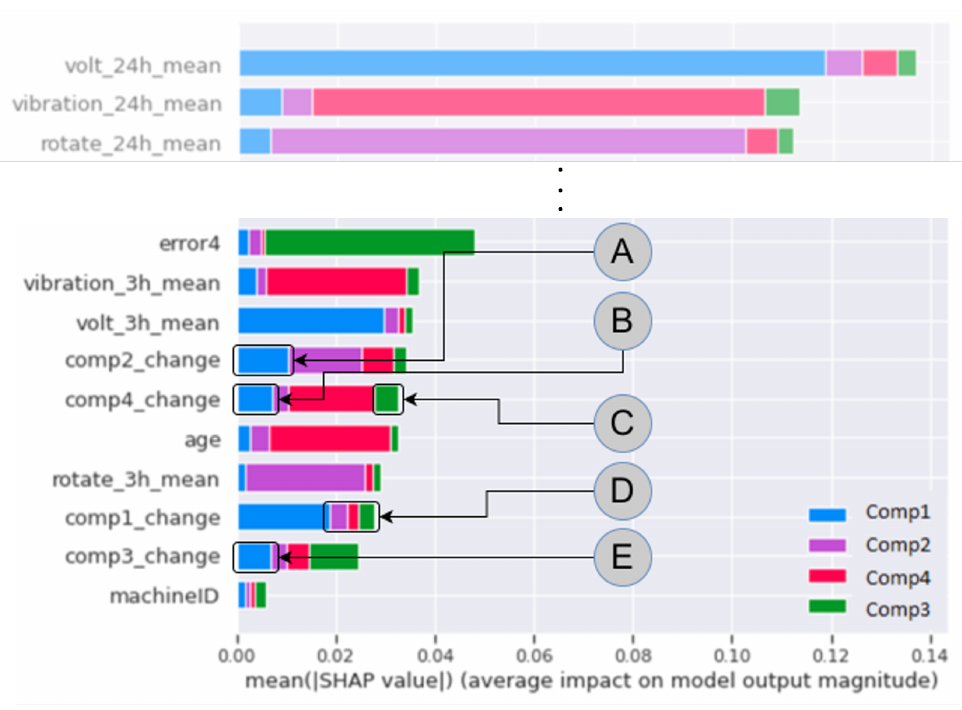
Figure 6. Estimation of feature importance with feature effects on prediction of all components or- dered by feature importance in the y-axis and on the x-axis by Shapley value. Features comp1_change, comp2_change, comp3_change, comp4_change show the contribution of corresponding time from last change of these components on the prediction of components failures (e.g., blue color shows the contri- bution of this feature on prediction of the failures for component